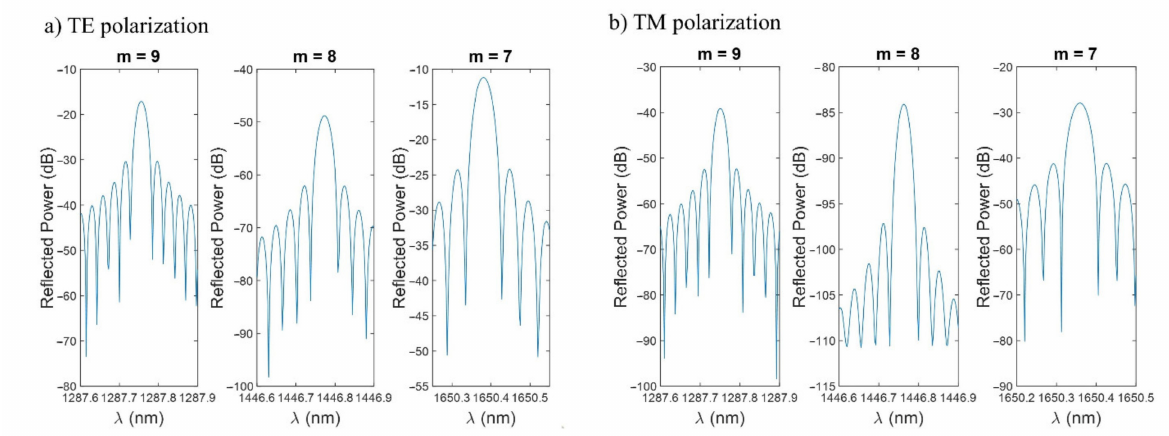
Figure 4. ( a ) Close-up of the FBG bands for a pitch of 4 µ m and TE polarization in the 1200–1800 range. ( b ) Close-up of the FBG bands for a pitch of 4 µ m and TM polarization in the 1200–1800